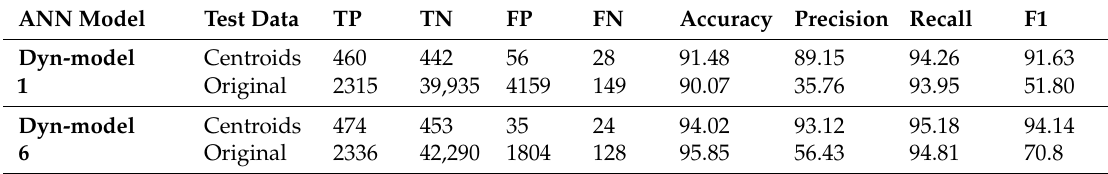
Table 7. Performance evaluation of the ANN models on the test data in the dynamic environment. ANN